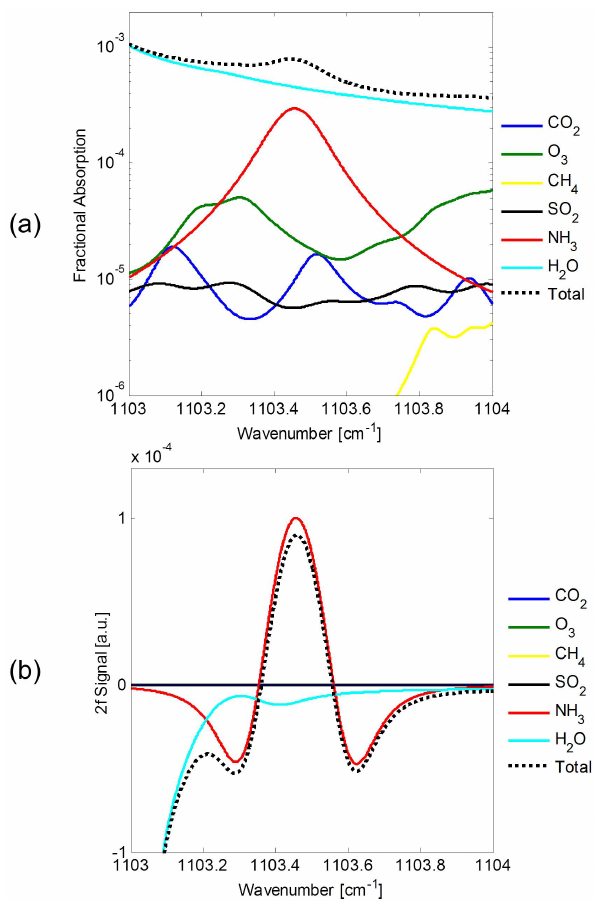
Fig. 2. (a) Direct absorption HITRAN simulation (Rothman et al., 2009) calculated based on 60m path length, 296K, 1013.25hPa and the following atmospheric mixing ratios: 400ppmv CO 2 , 80ppbv O 3 , 1800ppbv CH 4 , 5ppbv SO 2 , 1ppbv NH 3 and 2% H 2 O; (b) second harmonic spectrum calculated with same species show- ing reduction of the water vapor baseline. Ozone and CH 4 do not appear in the second harmonic spectrum as they are flat baselines. The black dotted lines in (a) and (b) denote the total absorption of all species